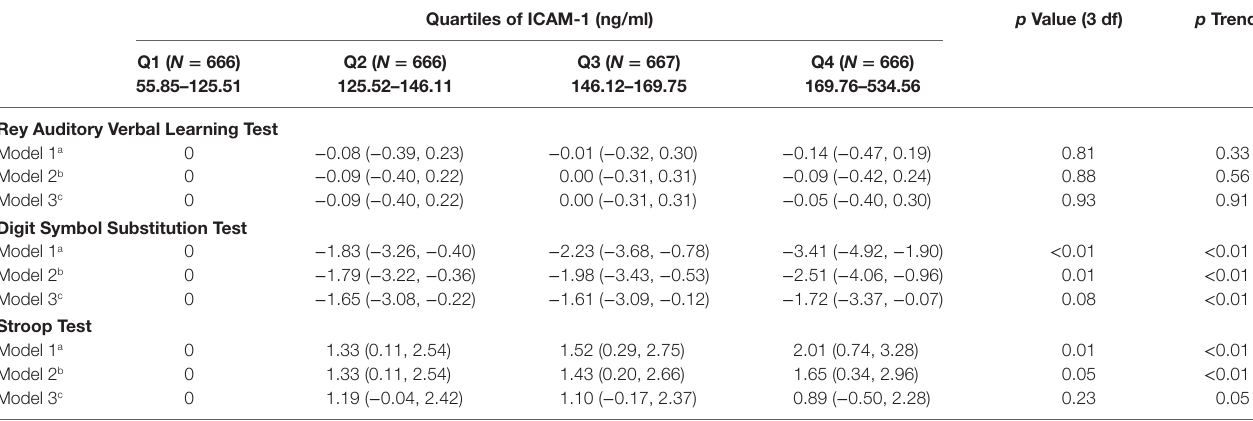
Table 4 | regression coefficients (95% ci) of year 25 cognitive test per year 15 intercellular adhesion molecule-1 (icaM-1) and e-selectin ( N = 2,665 for icaM-1). Quartiles of icaM-1